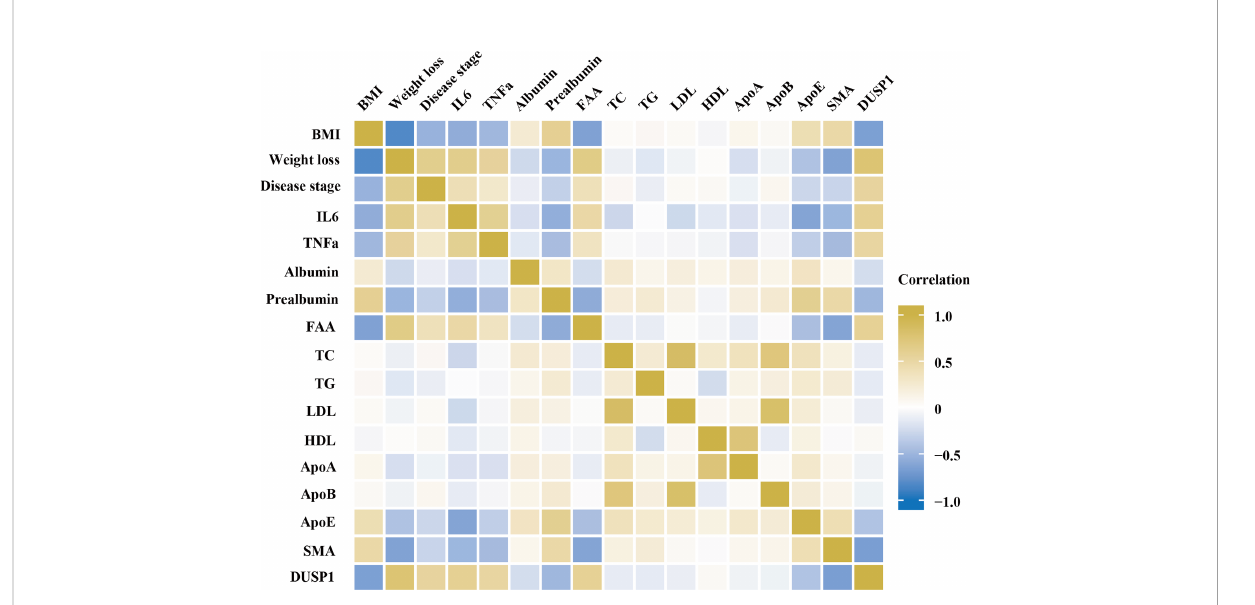
FIGURE 5 Spearman correlation matrix for variables. Yellow indicates positive correlations and blue indicates inverse correlations. Correlation strength is indicated by color intensity.